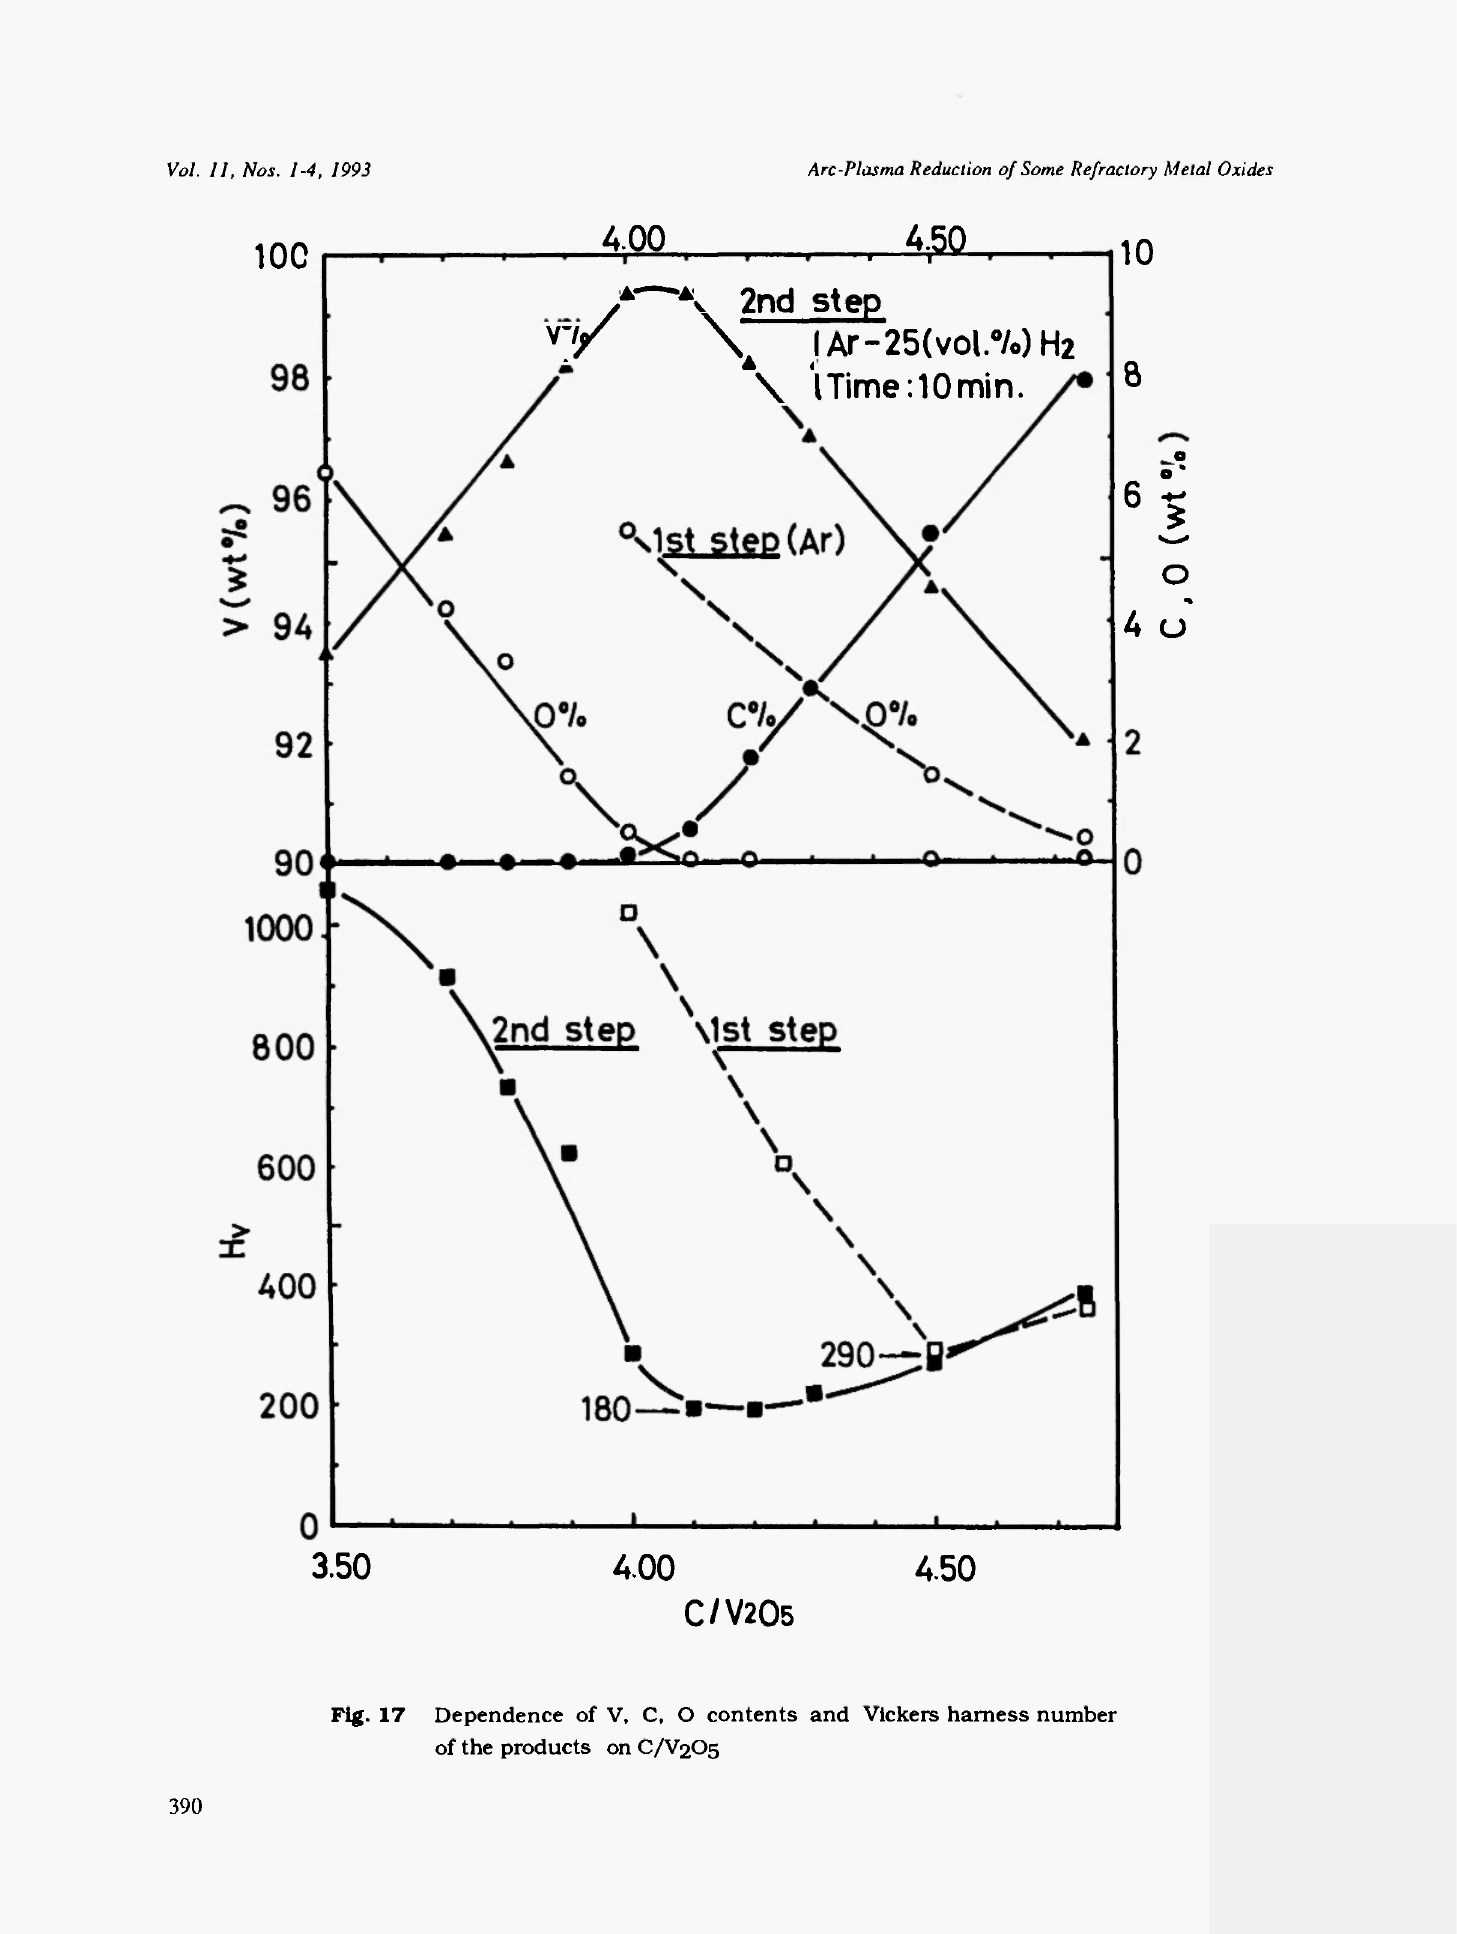
Fig. 17 Dependence of V, C, Ο contents and Vickers harness number of the products on